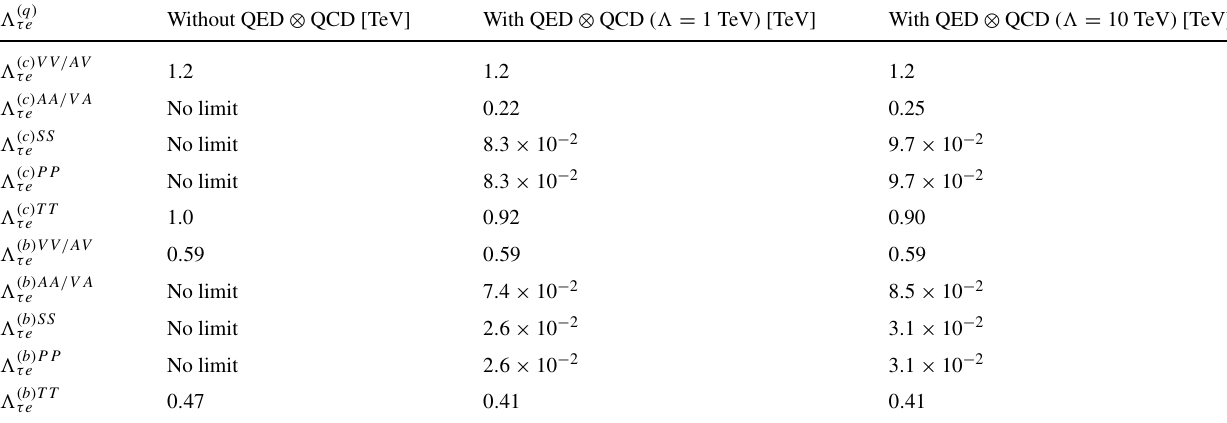
Table 3 Lower limits on the individual LFV scales (cid:7) further details